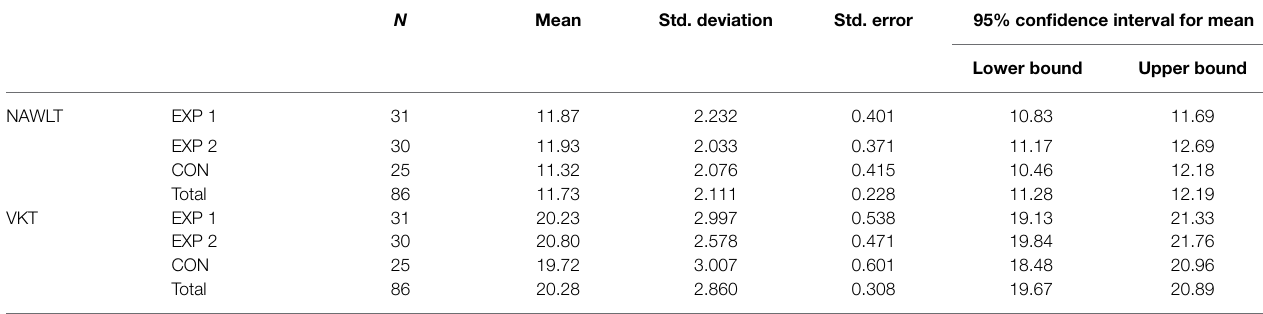
TABLE 1 | Descriptive statistics for pre-test results. N Mean Std. deviation Std. error 95% confidence interval for